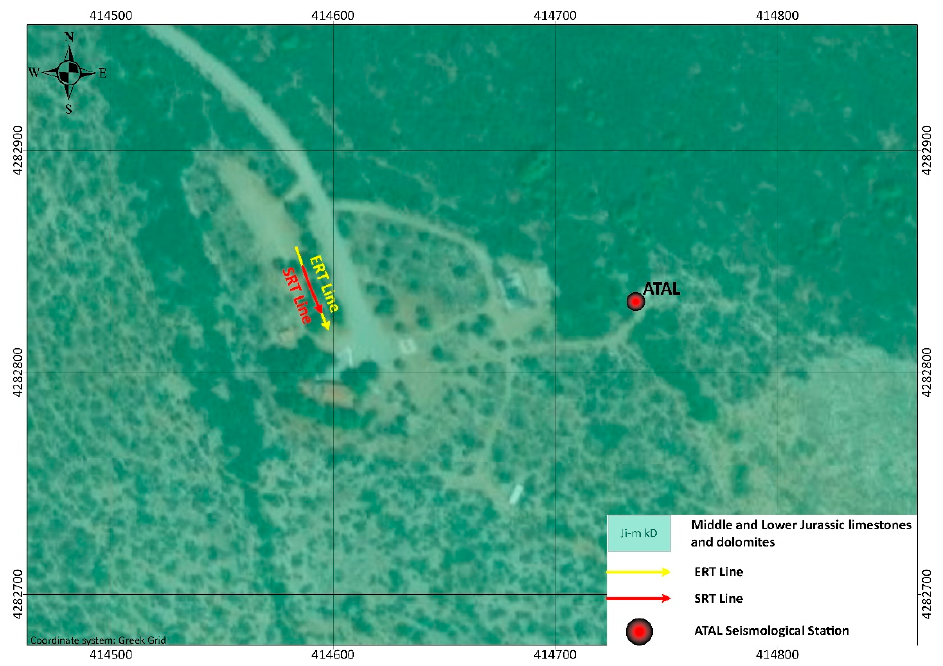
Figure 15. Location of the seismological station ATAL and the geophysical measurements along with the geology of the area.